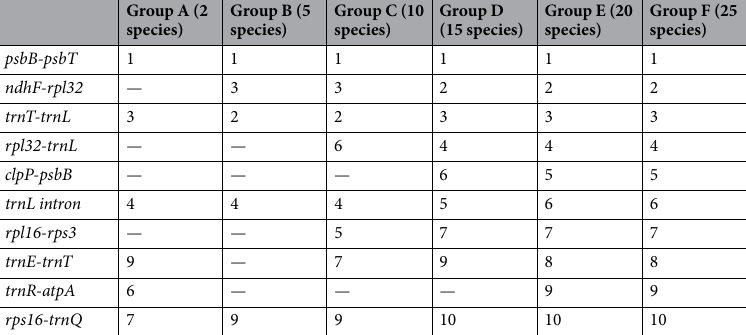
Group A (2 species)